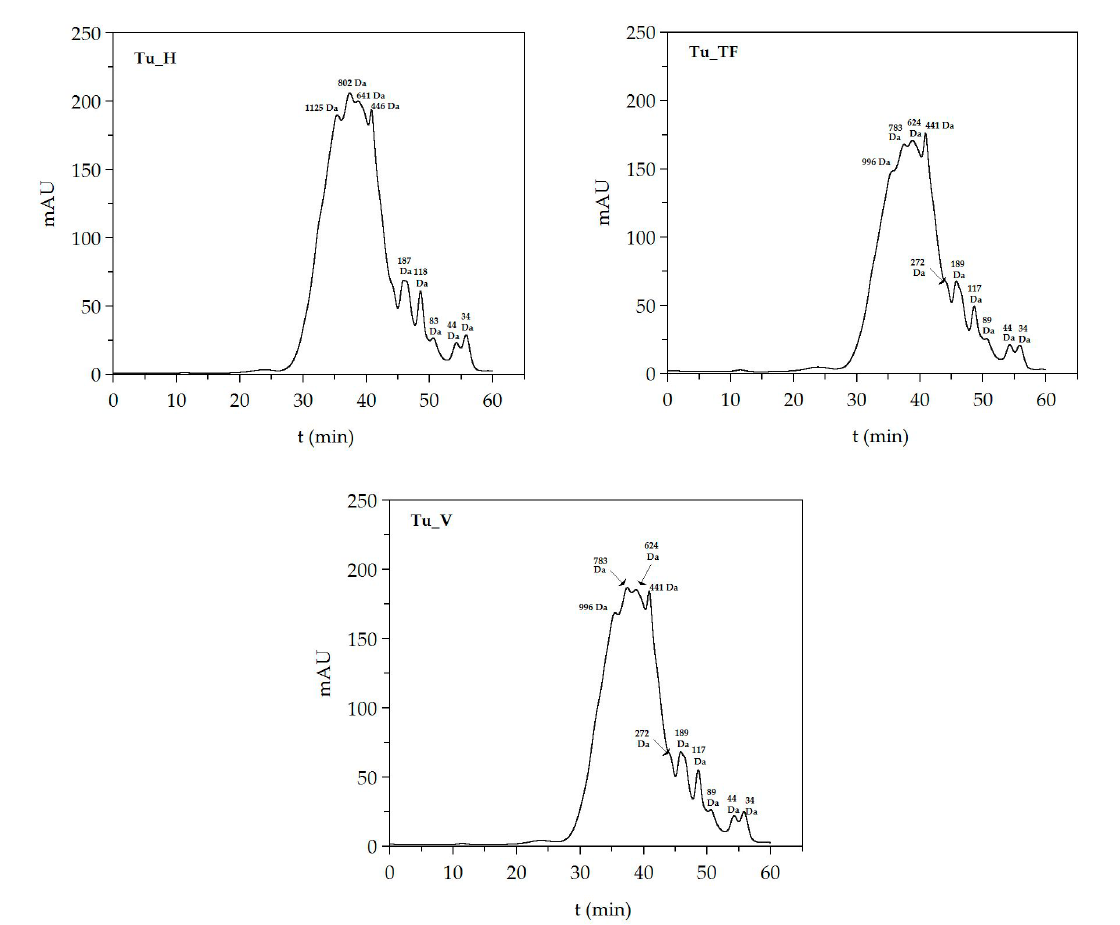
Figure 4. Size exclusion chromatographic profiles of turbot hydrolysates.